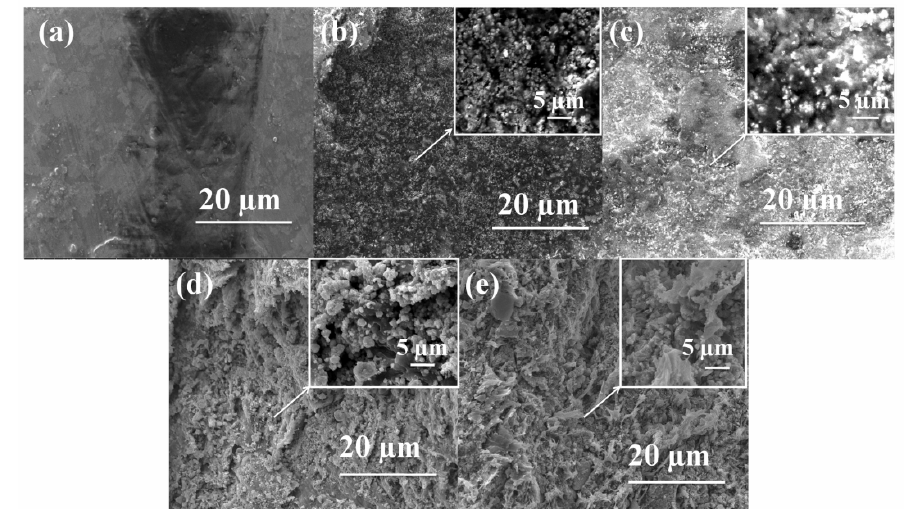
Fig. 4 Fractured cross-sectional SEM micrographs for hot-pressed PVDF–KNN nanocrystal composites: (a) hot-pressed PVDF, (b) PVDF–10 vol% KNN, (c) PVDF–20 vol% KNN, (d) PVDF–30 vol% KNN, (e) PVDF–40 vol% KNN, and the insets show the enlarged view of the corresponding images.